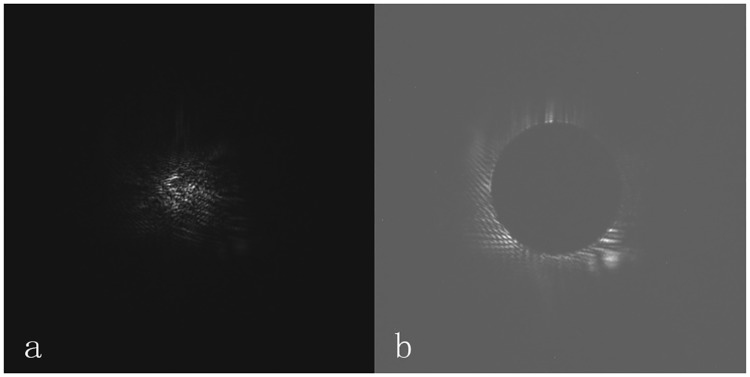
Images clipped for the first time.(a) The orgzb of the main lobe. (b) The orgpb of the side lobe.